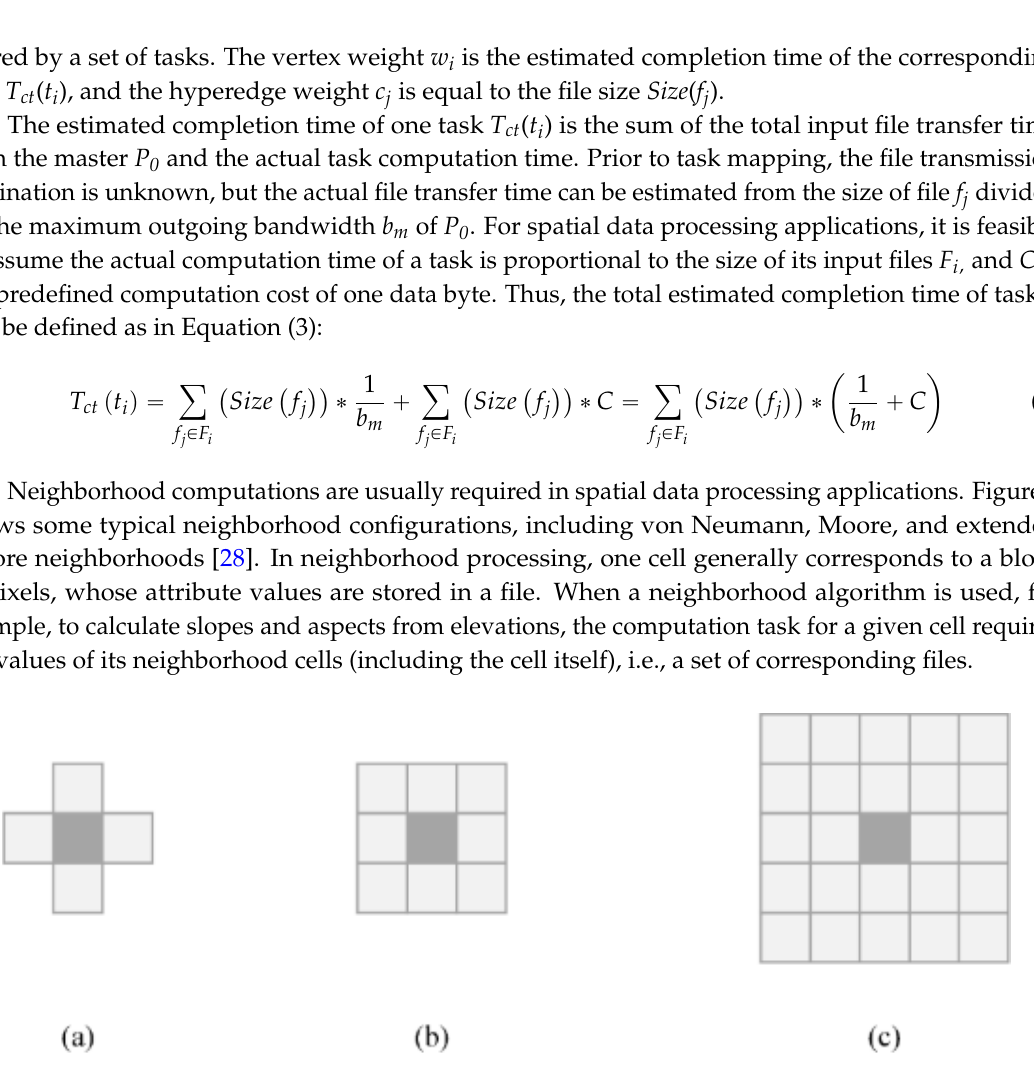
Figure 4. Typical and regular neighborhood configurations: ( a ) Von Neumann neighborhood, ( b ) Moore neighborhood, and ( c ) Extended Moore neighborhood.